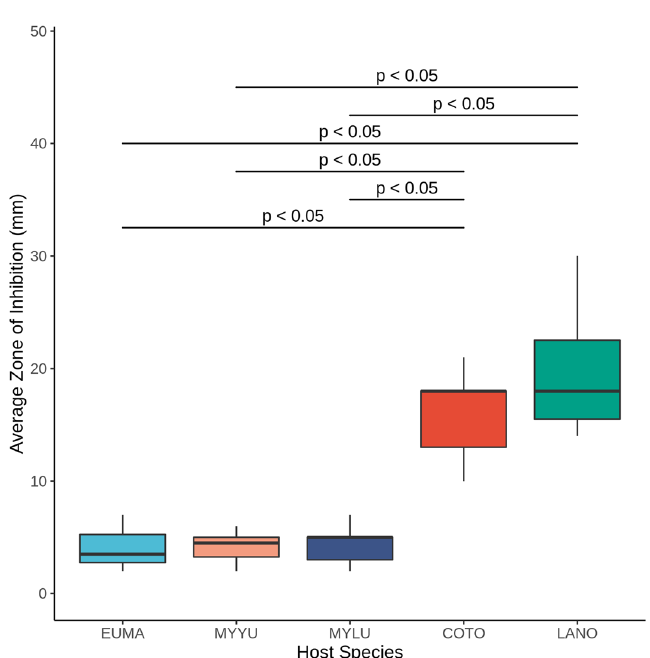
Figure 6. The inhibitory activity of bacterial isolates was measured in a coculture assay with Pd . Measurements of the average size of the zone of inhibition (ZOI) for bacterial isolates with partial inhibitory activity were compared between the different host species sampled in this study. A Wilcoxon rank test was used to compare differences in the ZOI between inhibiting isolates from different host species, only considering hosts with n ≥ 3 inhibiting